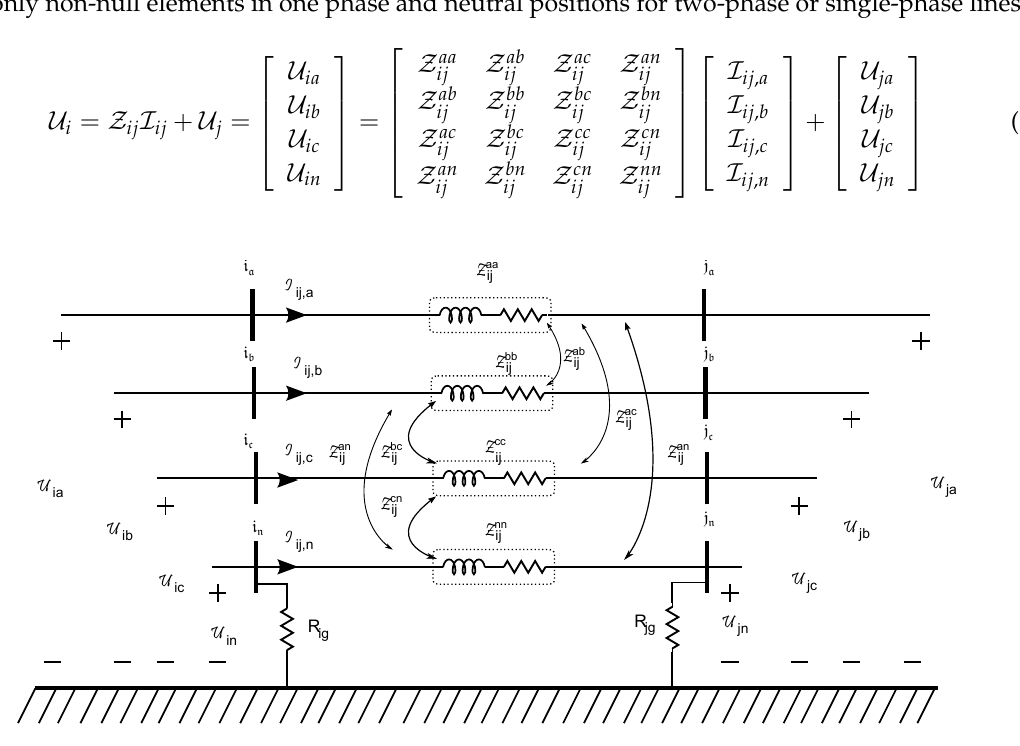
Figure 5. Three-phase four-wire electric line